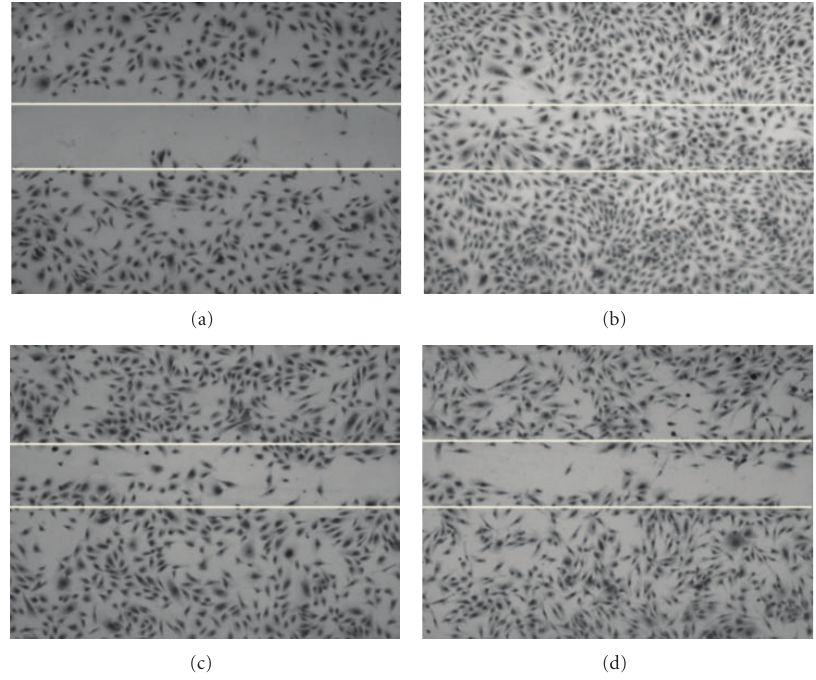
Figure 1: E ff ects of the standardized RVS extract on the migratory activity of VEGF-stimulated HUVEC (Wound-healing test). (a) The migrated cells in window-scraped field after scratching the cell monolayer; Control. (b) The wounds closed by cell migration from the wound edge after VEGF alone. (c) VEGF plus RVS (50 μ g/mL). (d) VEGF plus RVS (100 μ g/mL) showing inhibitory e ff ect on migration compared to only VEGF-treated control.